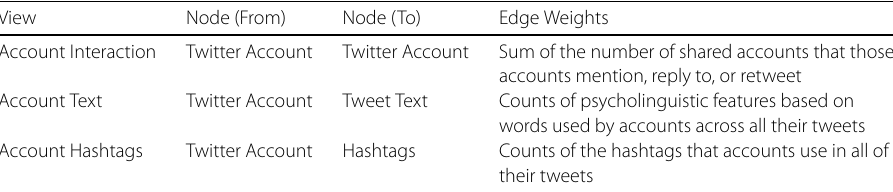
Table 2 Summary of network views used to process state-sponsored actors for multi-view modularity clustering View Node